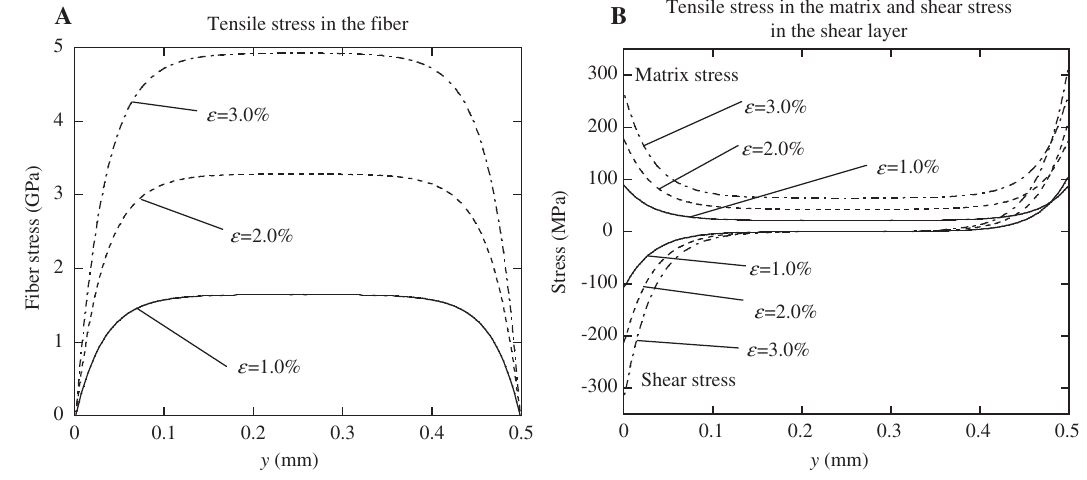
Figure 4 Stress distributions along the fi ber direction obtained by the present analysis in the linear elastic case.